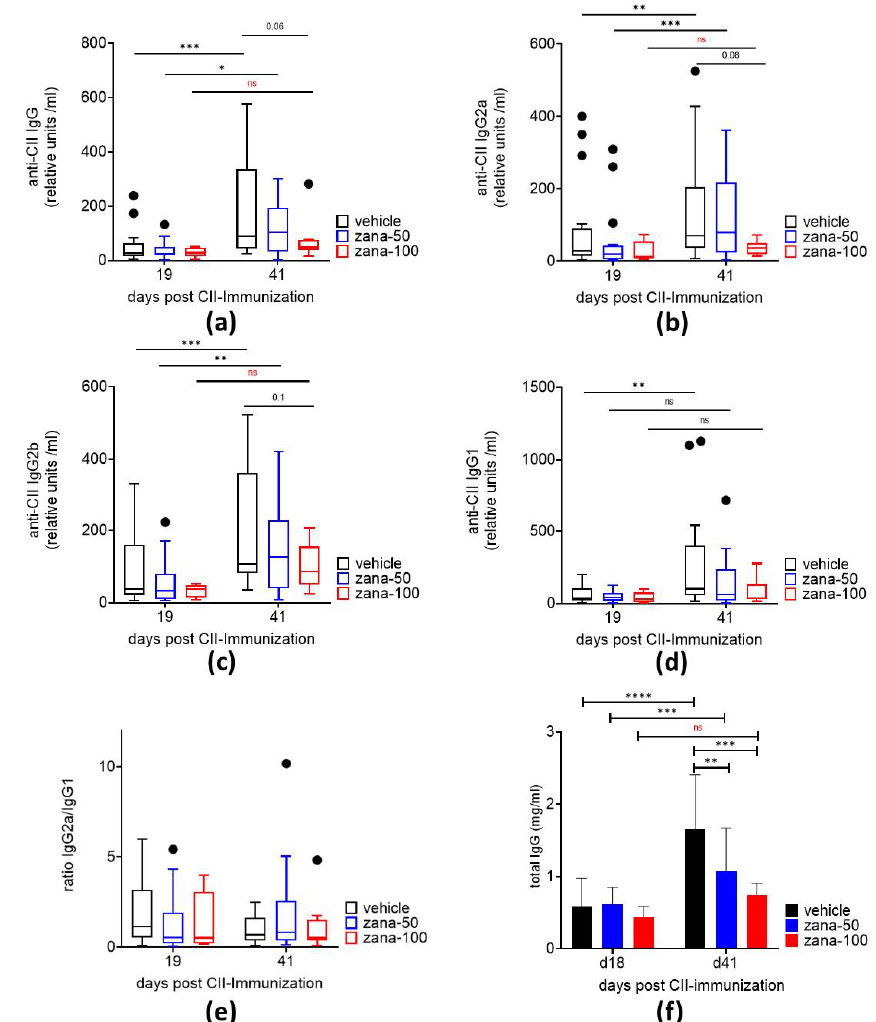
Figure 2. High-dose zanamivir prevents the increase in anti-CII IgG and total IgG levels in the arthritic phase of CIA. Serum levels of anti-CII IgG ( a ), anti-CII IgG2a ( b ) , anti-CII IgG2b ( c ) , and anti-CII IgG1 ( d ) antibodies in CIA mice. ( e ) Anti-CII IgG2a: anti-CII IgG1 ratio. Data (a-e) are presented as Tukey’s box- and whisker plots. Observations outside the whiskers are considered outliers and presented as black dots. ( f ) Serum levels of total IgG. Results are shown as ± standard deviation ( ± SD). * p ≤ 0.05; ** p ≤ 0.01; *** p ≤ 0.005; **** p ≤ 0.0001. ns = not significant. Two-way ANOVA for repeated measures with Sidak’s or Tukey’s multiple comparisons